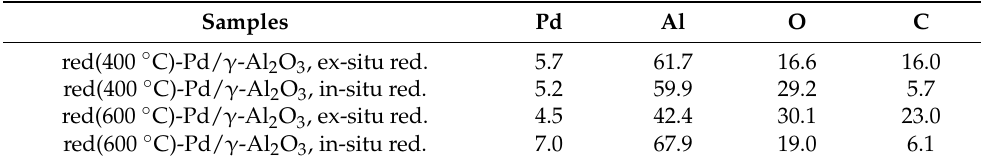
Pd/ γ -Al 2 O 3 and red(600 ◦ C)-Pd/ γ -Al 2 O 3 , analysed after being air exposed (ex-situ red) and after in-situ H 2